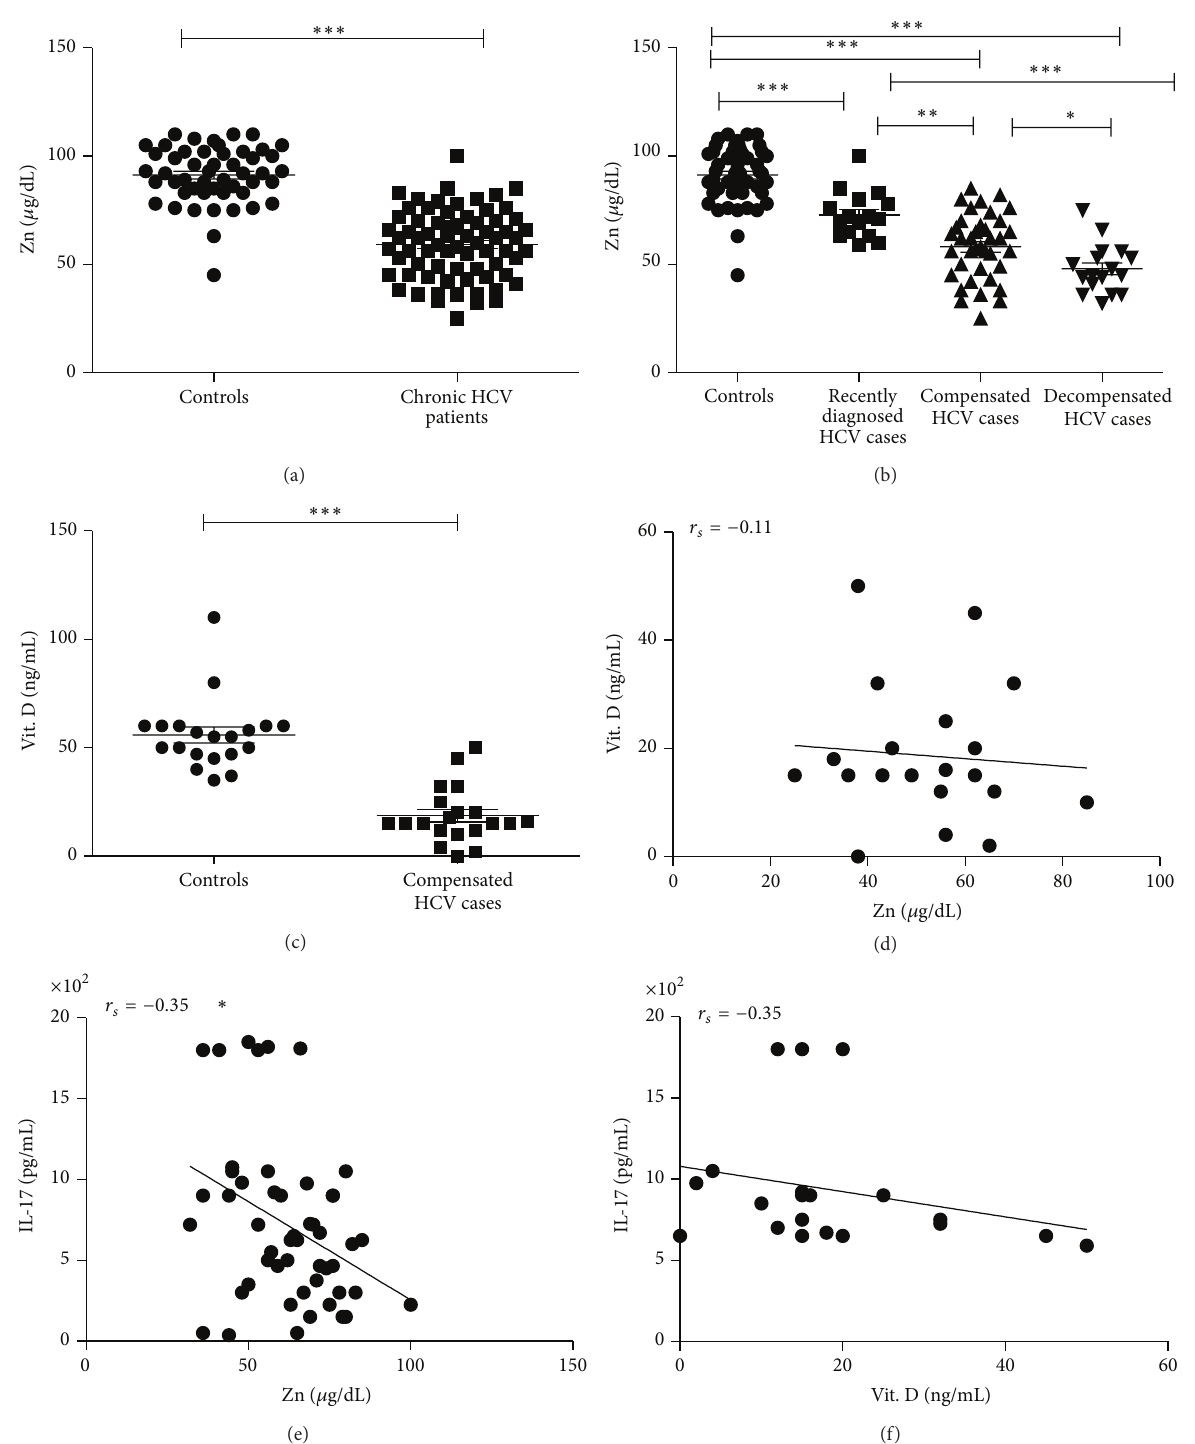
Figure 2: Lower Zn level in chronic HCV patients (a). Statistically significant differences in Zn level across the different groups are indicated (b). Lower Vit. D level in the selected compensated patients compared to controls (c). Correlation between Zn and Vit. D was nonsignificant Spearman coefficient ( 𝑟 𝑠 = −0.11 ) (d). IL-17 was correlated with Zn (e) and Vit. D (f) and Spearman coefficient was calculated ( 𝑟 𝑠 = −0.35 ). ∗ indicates 𝑃 < 0.05 ; ∗∗ indicates 𝑃 < 0.01 ; and ∗ ∗ ∗ indicates 𝑃 < 0.001